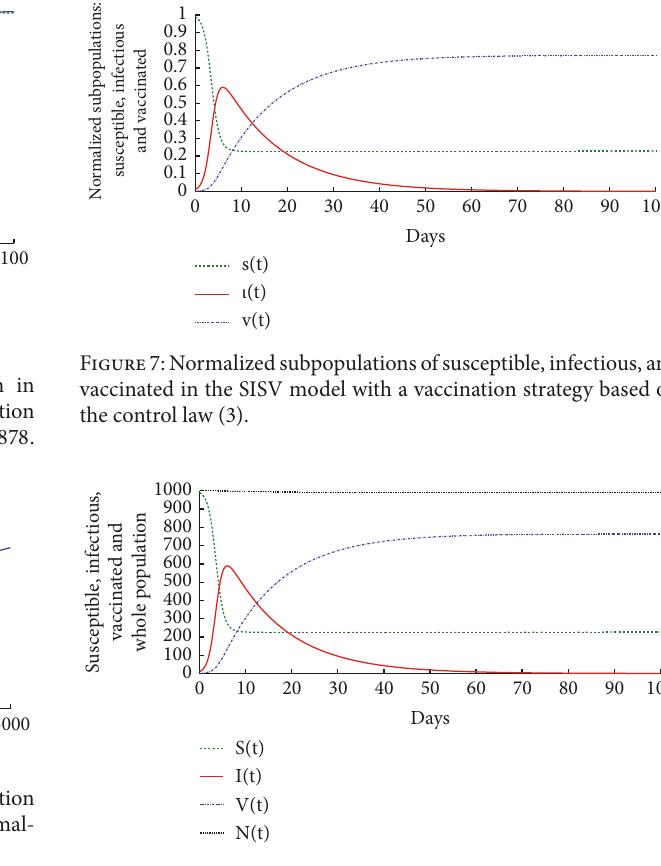
Figure 8: Susceptible, infectious, vaccinated, and whole population in the SISV model with a vaccination strategy based on the control law